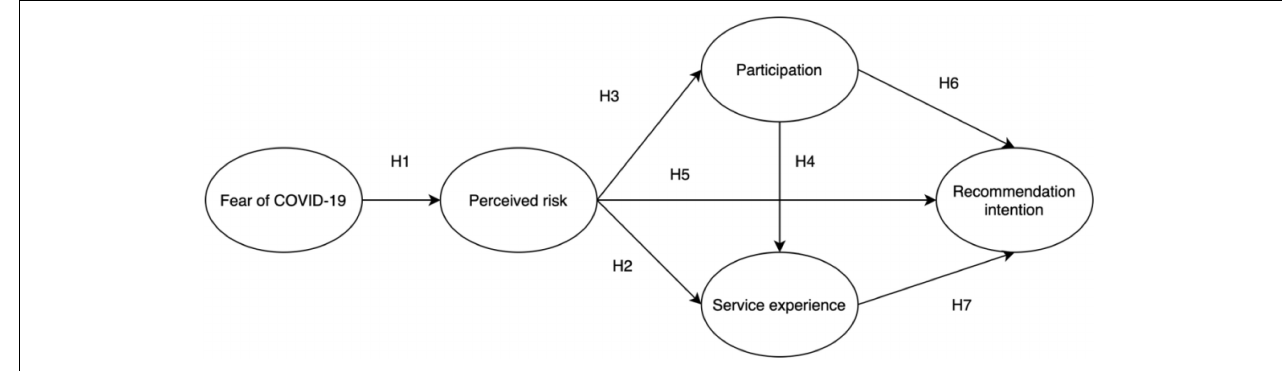
FIGURE 1 | Conceptual